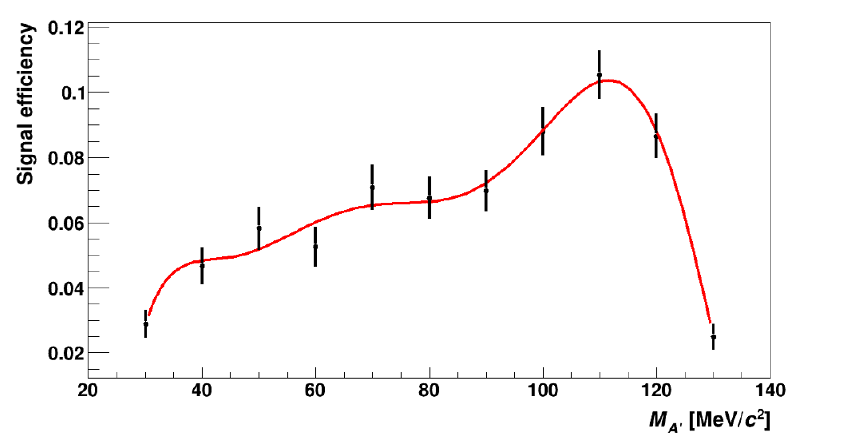
Figure 5 . Total e(cid:14)ciency as a function of M A 0 . A polynomial function is used to interpolate the global e(cid:14)ciency in the range 30 < M A 0 < 130 MeV/ c 2